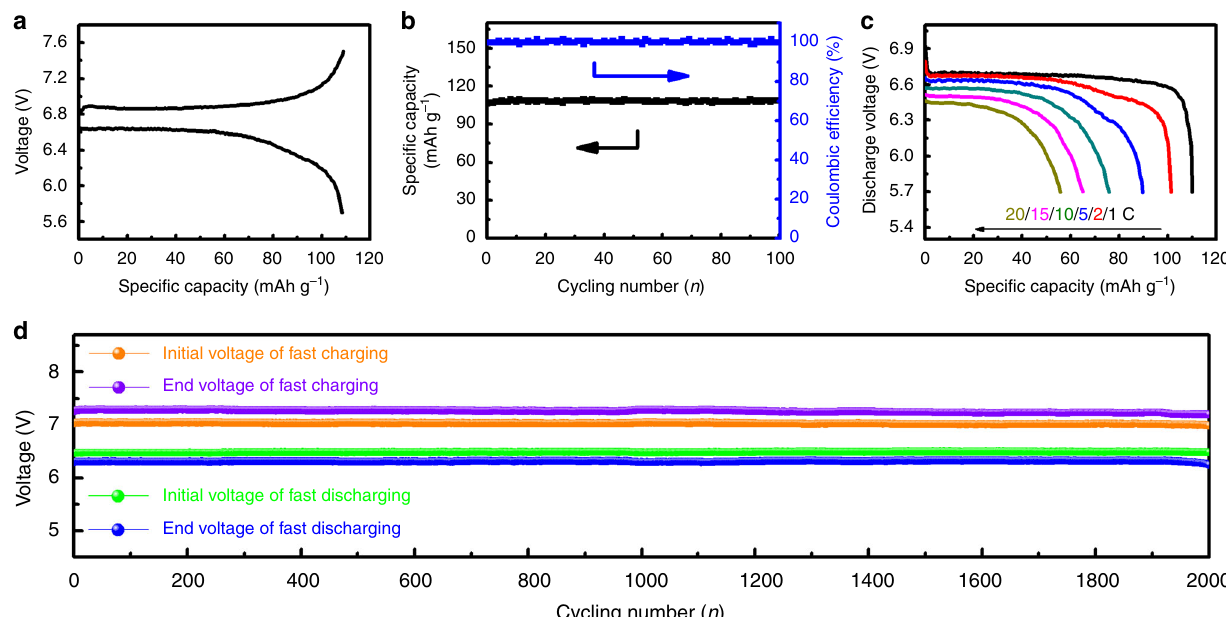
Fig. 2 Electrochemical behavior of a two-unit bipolar NIB cell. a Initial charge and discharge curves at 1 C in a voltage range from 5.7 to 7.6 V. b Cycling 100 times at 1 C. c Rate capabilities from 1 to 20 C. d The voltages of long cycles at the beginning and the end of each step under fast charge/discharge